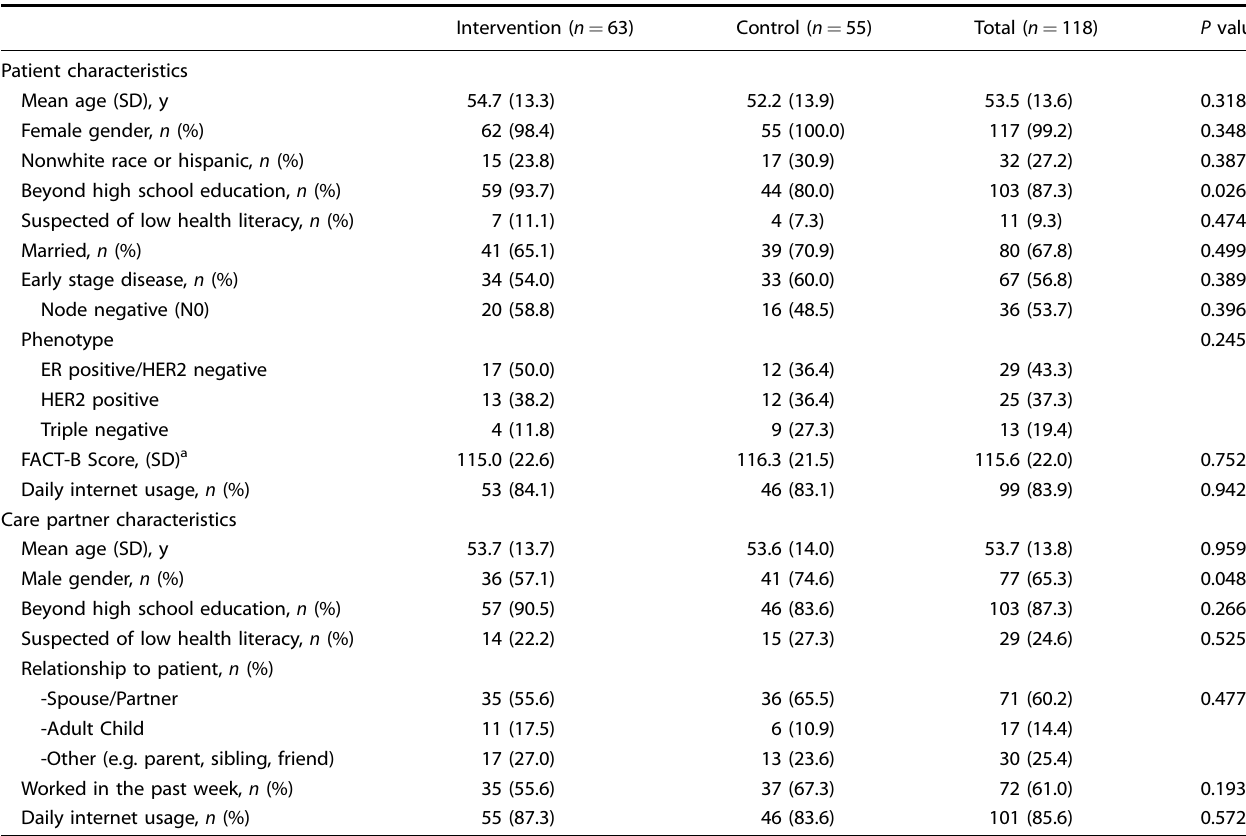
Table 1. Study participant characteristics by group